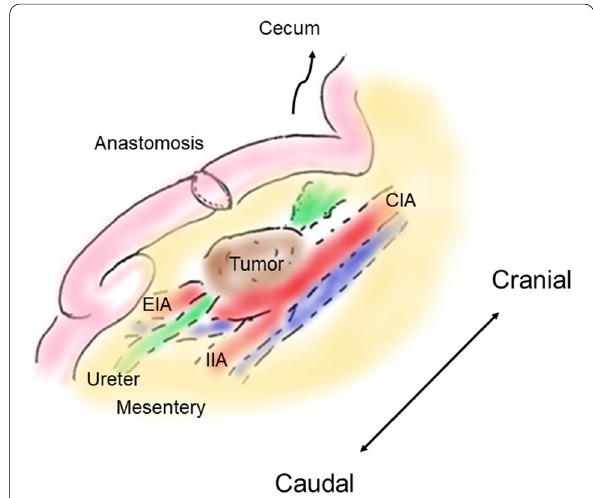
Fig. 2 Intraoperative figure. The tumor was located in the mesentery near the anastomosis of ileostomy closure and it was strongly adherent to the retroperitoneum, which obstructed the right ureter. CIA common iliac artery, EIA external iliac artery, IIA internal iliac artery